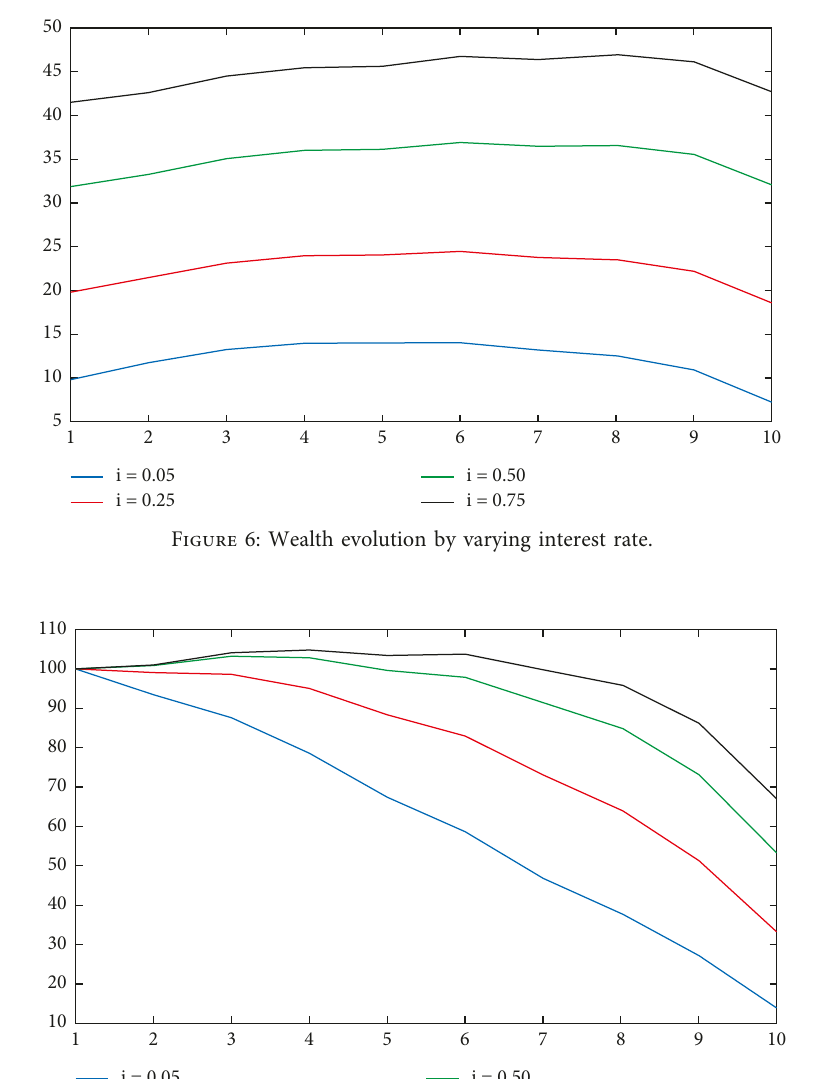
10 6 with interest rate i ×